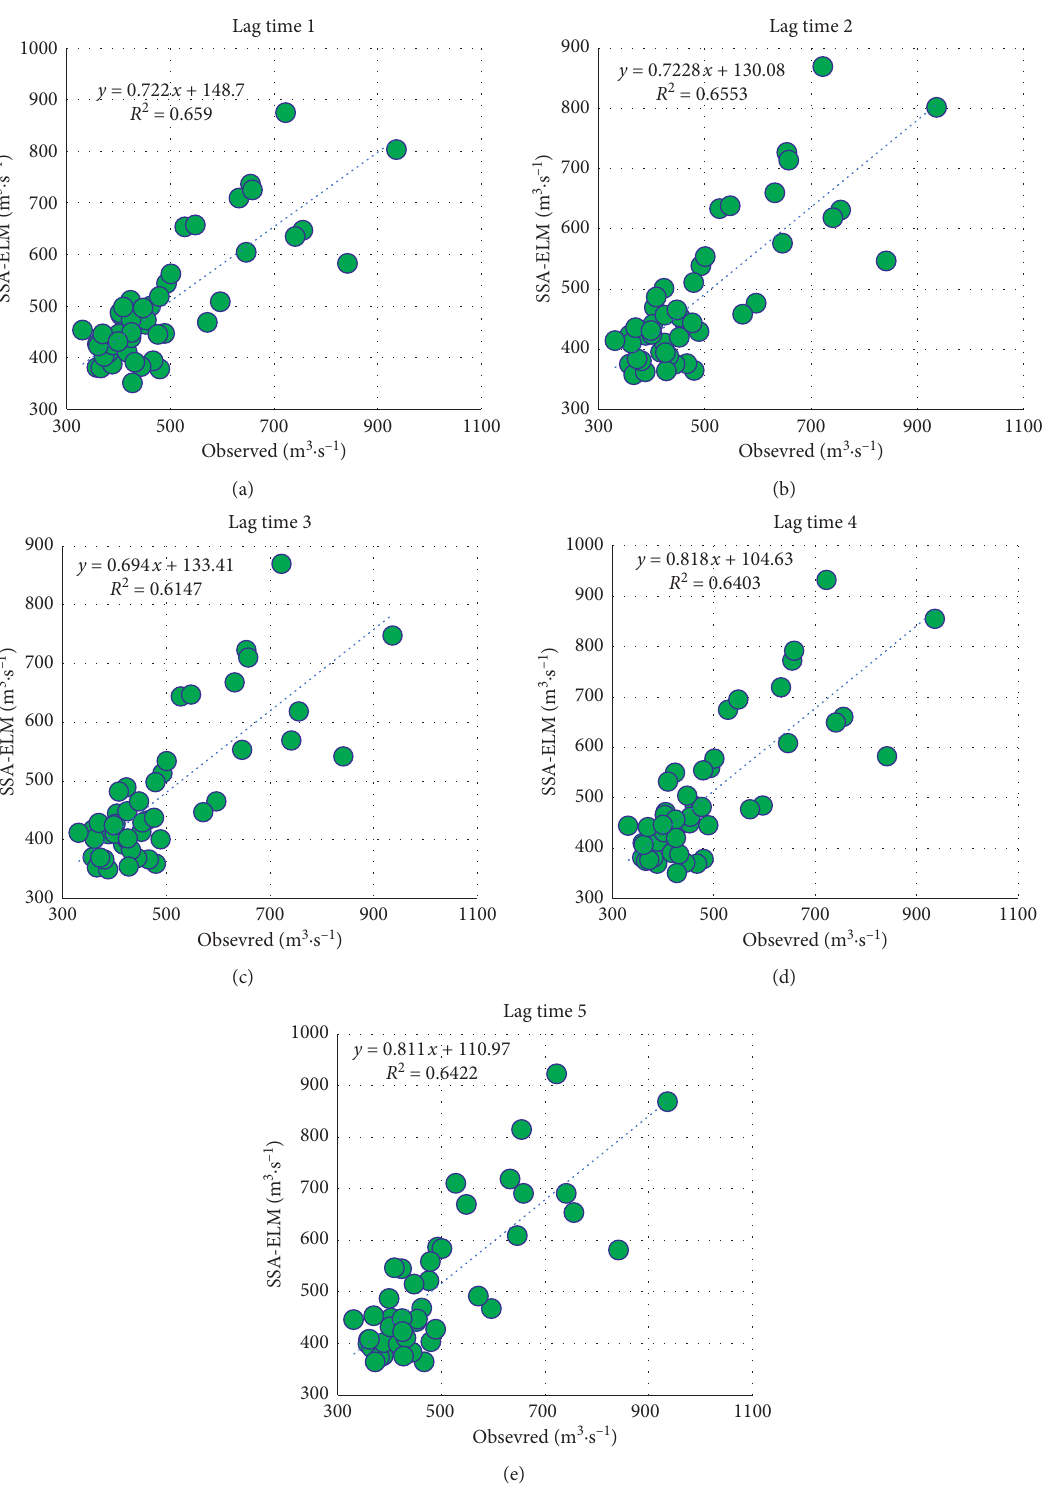
Figure 10: Scatter plot variation between the observed and forecasted river flow using the SSA-ELM model and for the five input